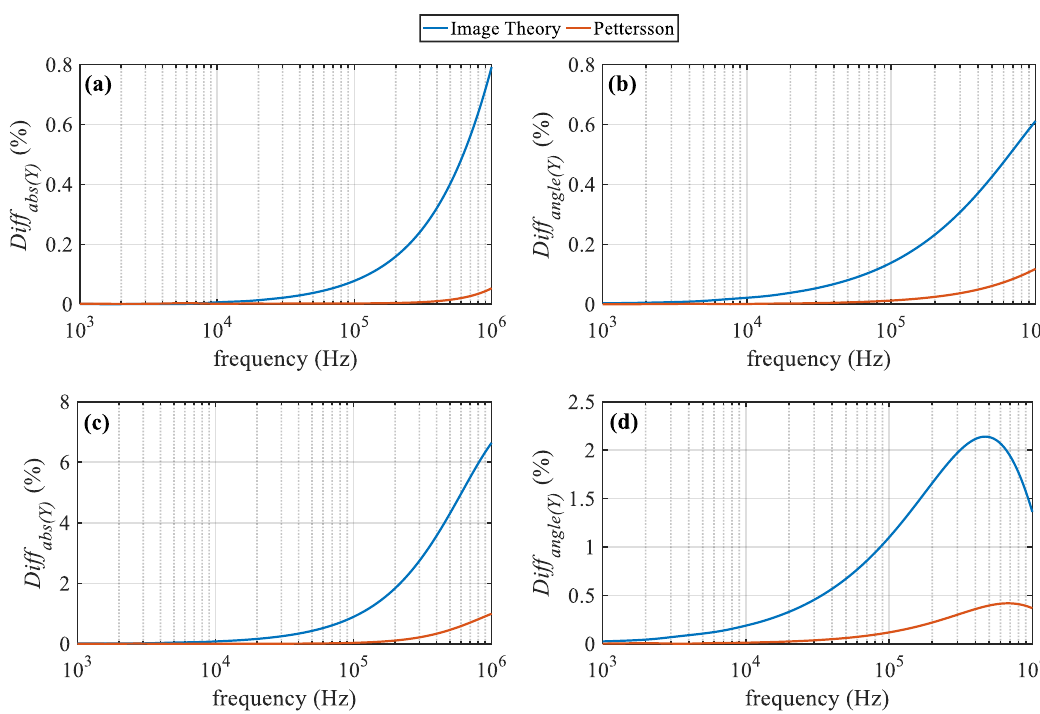
Figure 19. Di ff erences in Y 13 at the NB frequency zone. For ρ g = 100 Ω m, ε rg = 10, ( a ) magnitude, Energies 2020 , 12 , x FOR PEER REVIEW 19 of 29 Figure 19. Differences in Y 13 at the NB frequency zone. F or ρ g = 100 Ωm, ε rg = 10, ( a ) magnitude, ( b ) ( b ) angle, for ρ g = 1000 Ω m, ε rg = 10, ( c ) magnitude and ( d ) angle. angle, for ρ g = 1000 Ωm, ε rg = 10, ( c ) magnitude and ( d ) angle.